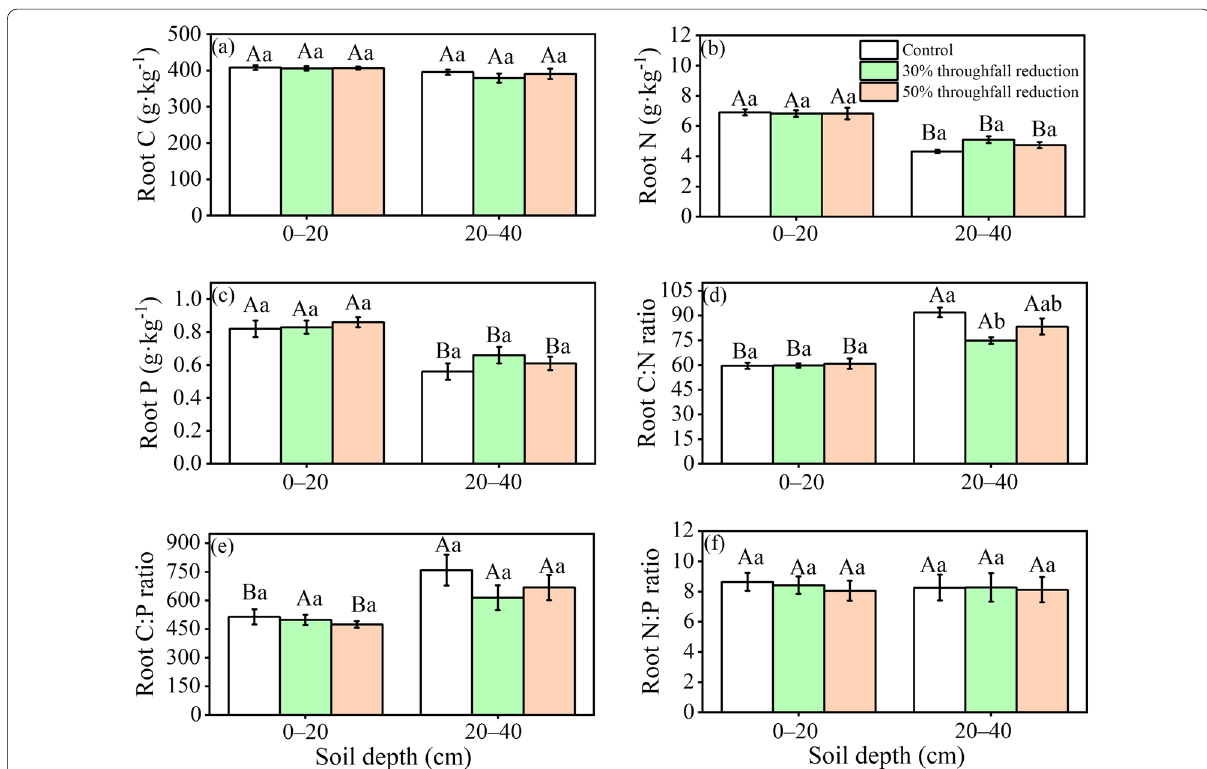
Fig. 5 Effect of drought on fine‑root C, N, P concentrations, C:N ratio, C:P ratio and N:P ratio (Mean uppercase letters above the bars indicate significant differences between soil layers at each drought treatment, and different lowercase letters above the bars indicate significant differences among three drought treatments at each soil